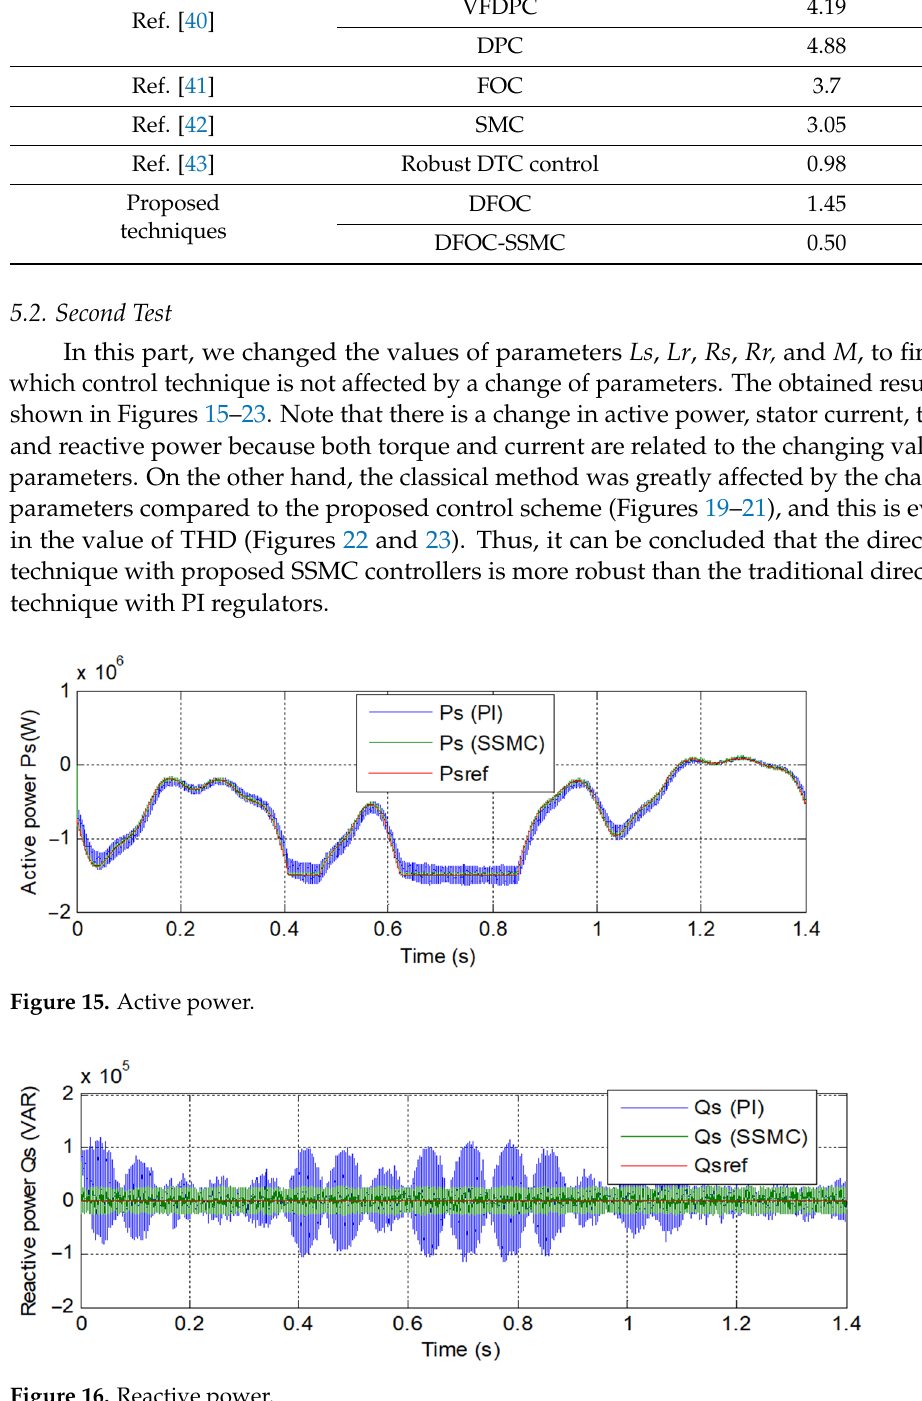
Table 2. Comparison of the obtained results with other methods.